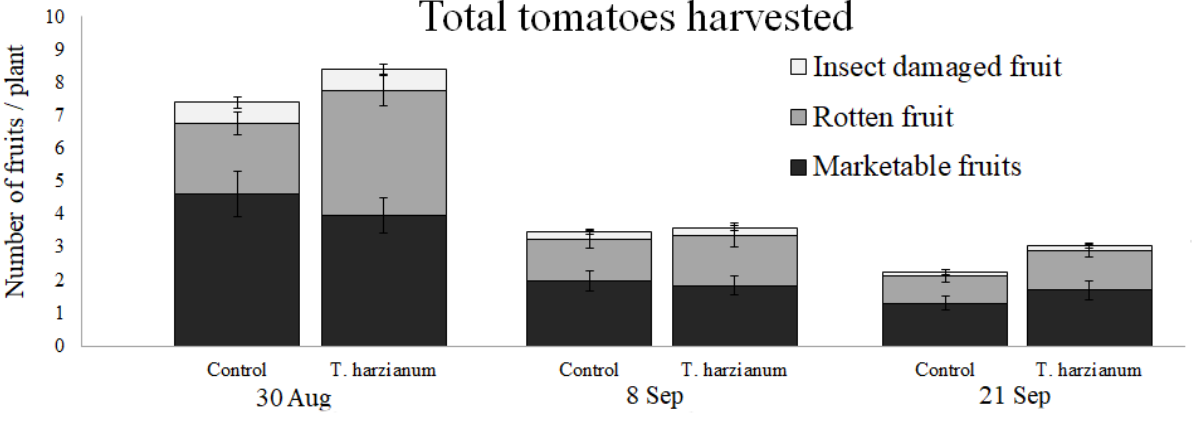
Figure 9. Mean number of tomato fruit ( ± standard errors) harvested per plant in the two experimental treatments during the three sampling dates.